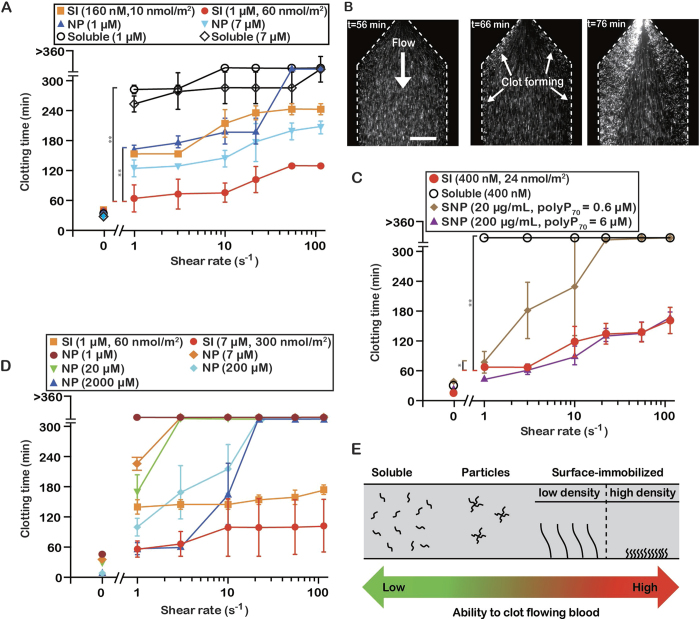
PolyP accelerates clotting best when spatially localized onto surfaces, compared to soluble polyP and nanoparticles of polyP.(A) Clotting times of plasma by polyP160 at varying shear rates, comparing three states of polyP160: solubilized, self-assembled nanoparticles, and surface-immobilized. (B) Time-lapse images showing SI-polyP160 initiating clotting (detected by non-flowing beads) from the channel wall (dashed lines). Scale bar is 250 μm. (C) Comparing three states of polyP70: solubilized, surface-immobilized onto the microfluidic channels, and immobilized onto silica nanoparticles. Clotting tendencies of plasma containing silica nanoparticles coated with polyP70 (SNP-polyP70) compared to soluble and surface-immobilized polyP70 under shear in the microfluidic device. (D) Comparing two states of long-chain polyP: surface immobilized polyP400 and nanoparticles of self-assembled polyP>1000. (E) Schematic summarizing the relationship between spatial distribution of polyP and the acceleration of clotting in the above experiments. Data points indicate mean ± SEM, *p < 0.001, **p < 0.0001, n = 3–4. Statistical analysis represents comparisons between whole curves.